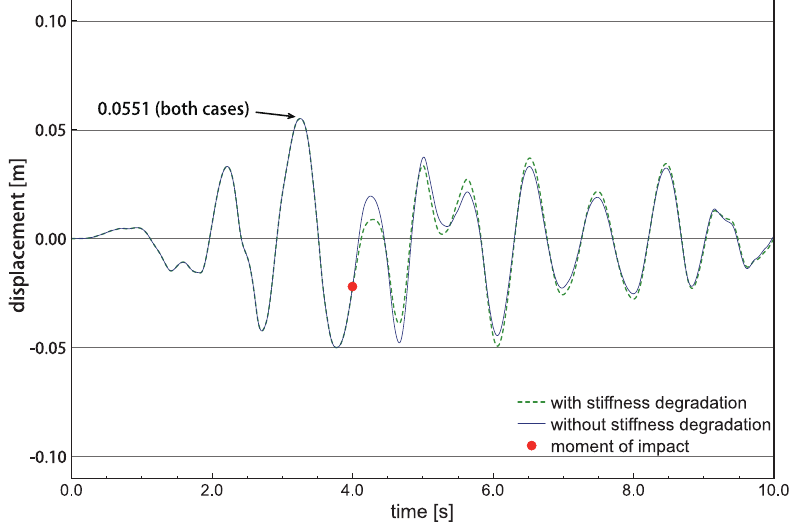
Fig. 8. Displacement time history of the first story of building under the El Centro earthquake with and without considering the degradation of horizontal stiffness for impact at t = 4 s.